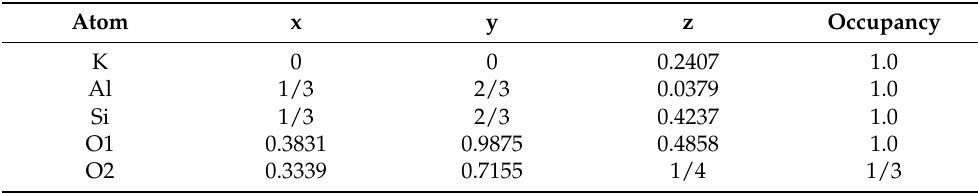
Table 3. Fractional atomic coordinates, occupancies, and isotropic thermal parameters of kalsilite ob- tained from the GSAS Rietveld Refinement using X-ray powder diffraction data at room temperature.